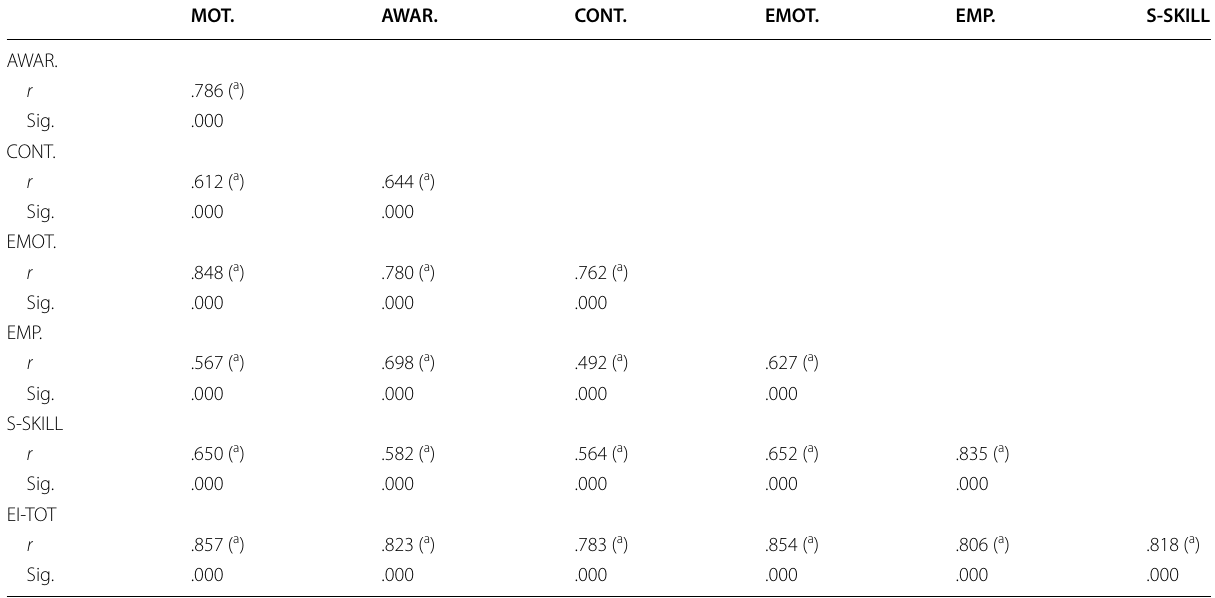
Table 3 Results of Pearson’s correlations between the different factors ( N